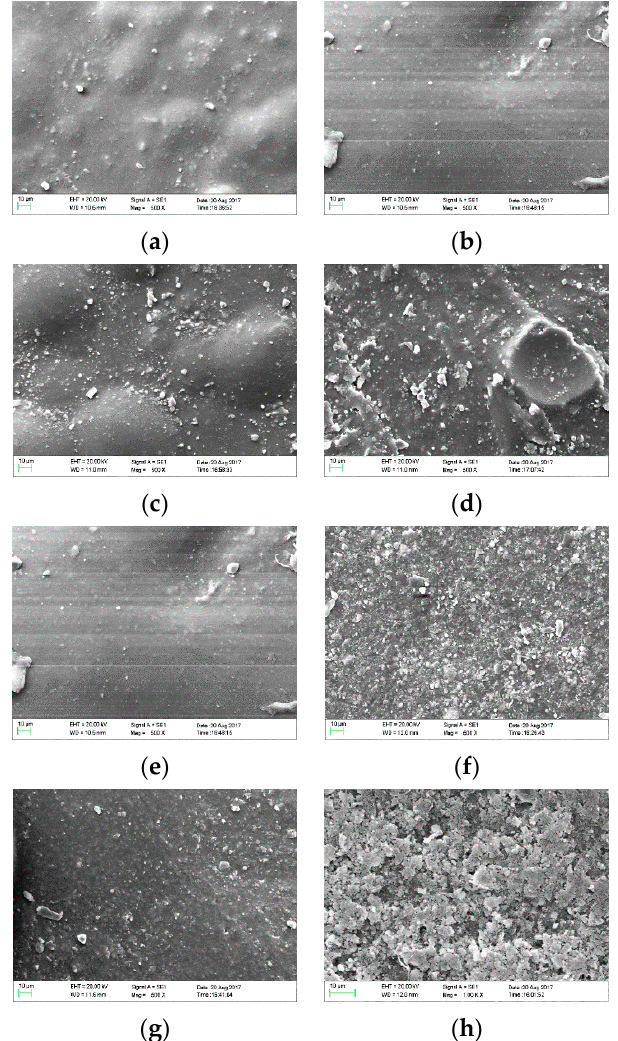
Figure 13. The RTV micro-morphology at different periods. ( a ) 1 month (No algae). ( b ) 1 month (Algae). ( c ) 4 months (No algae). ( d ) 4 months (Algae). ( e ) 7 months (No algae). ( f ) 7 months (Algae). ( g ) 10 months (No algae). ( h ) 10 months (Algae).